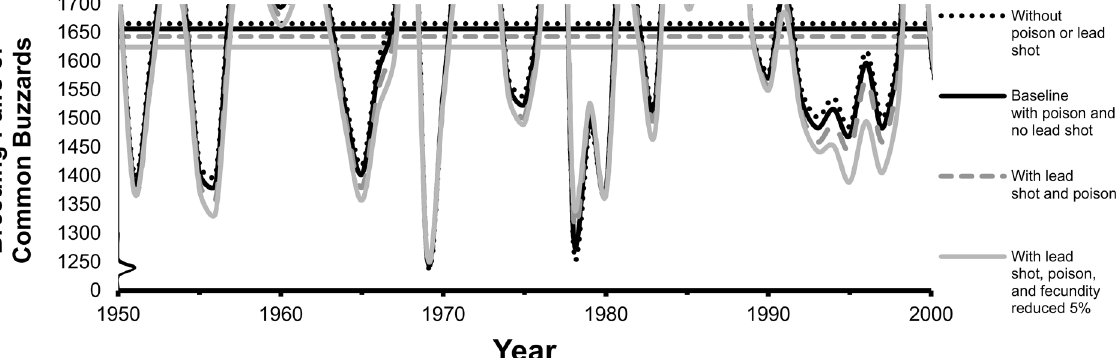
Fig 5. Comparison of the common buzzard steady-state population size and one example trajectory for four scenarios. The steady state (horizontal line) is the mean of 10,000 trajectories. Scenarios include with and without ingestion of lead shot (shown at upper-bound rate of 5% of total mortality) and bait poison (at 4% of total mortality), plus the sensitivity analysis with 5% reduction in fecundity added to mortality effects. The upper part of the example trajectory is not shown to amplify the lower part of the